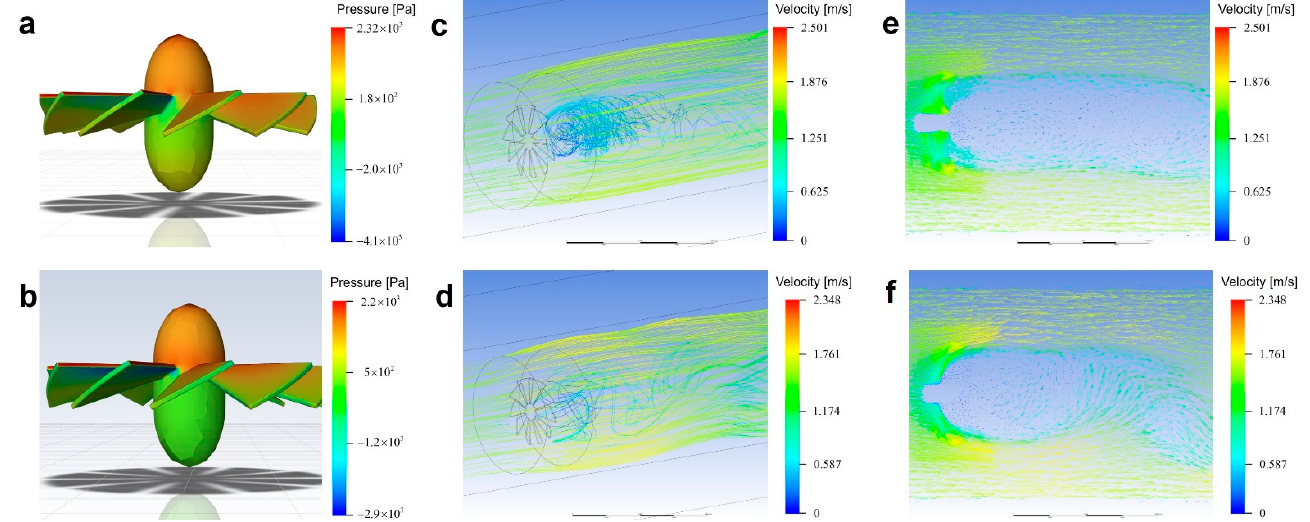
Figure 8. ( a ) Dynamic pressure distribution of passive morphing ‐ blade group; ( b ) dynamic pressure distribution of flat ‐ blade group; ( c ) path line around the tail of passive morphing ‐ blade group; ( d ) path line around the tail of flat ‐ blade group; ( e ) flow plane around the tail of passive morphing ‐ blade group; ( f ) flow plane around the tail of flat ‐ blade group. Table 2. Parameters of wake